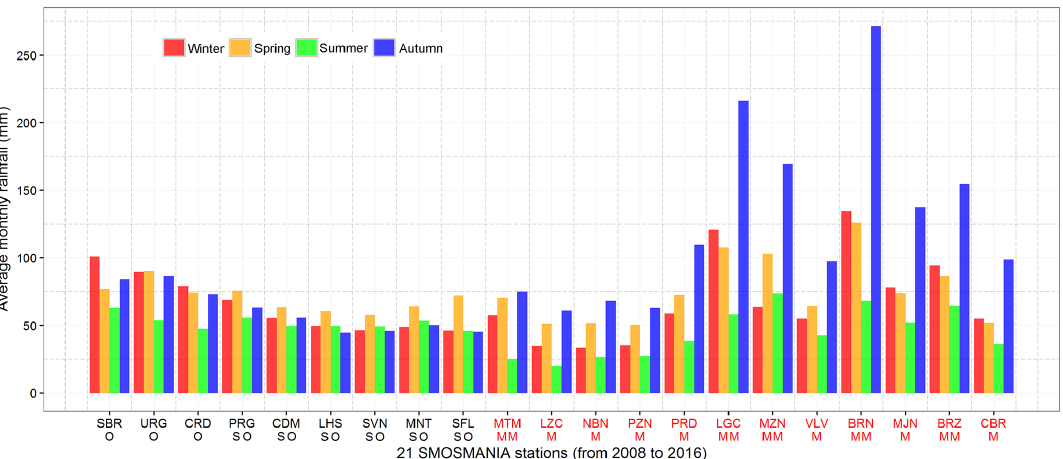
Figure 3. Average monthly rainfall (in units of mm) for the 21 SMOSMANIA stations across seasons from 2008 to 2016. Stations are sorted from (left) west to (right) east. Symbols “O”, “SO”, “M”, and “MM” indicate oceanic, semi-oceanic, Mediterranean, and Mediterranean– mountain climates, respectively. Winter season is from December to February.